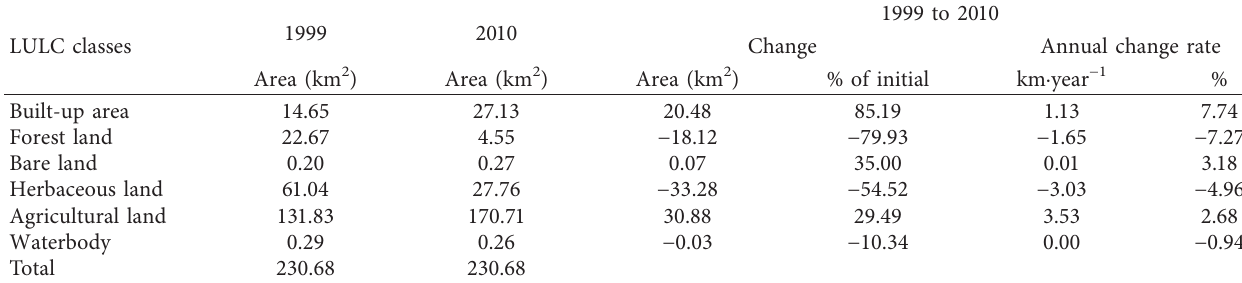
Table 7: LULC class annual change rate from 1999 to 2010.